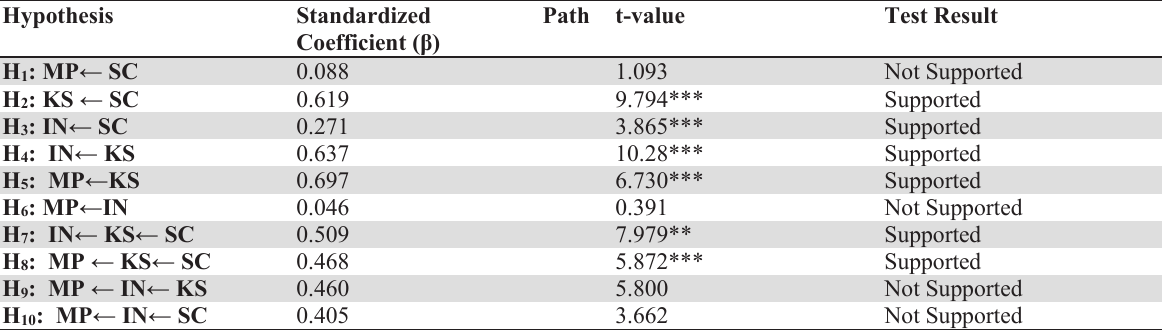
Hypothesis Result of the Structural Model